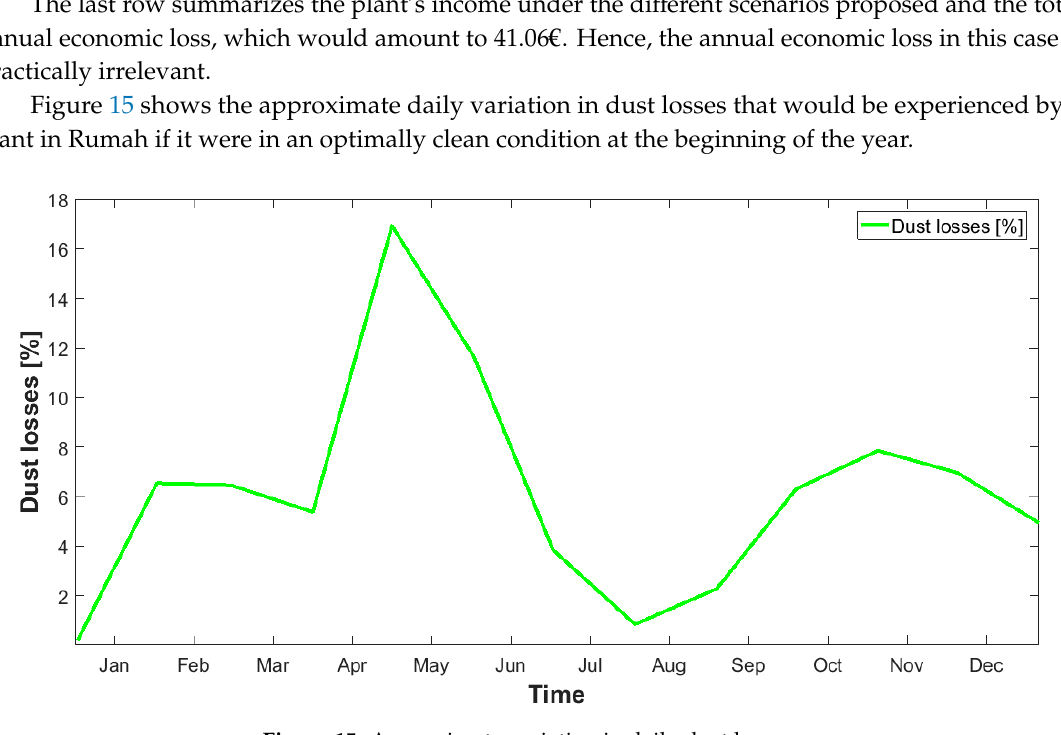
Figure 15. Approximate variation in daily dust losses.